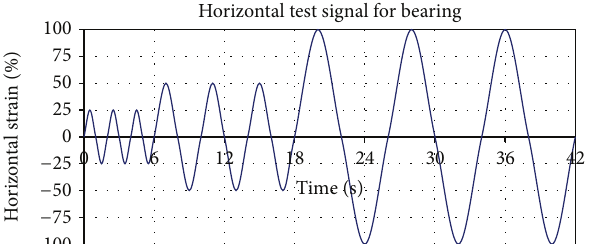
Figure 3: Input signal for horizontal shear test with 3.45 MPa and 6.90 MPa vertical